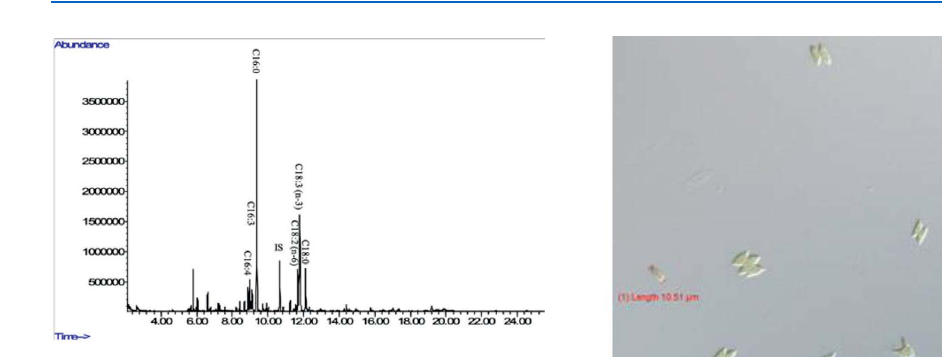
Fig. 5c. GC-MS chromatograms of FAME derived from freeze-dried biomass of freshwater green algae Chlorella vulgaris NIES-1269 (see Table 2 for peak identification). * Heptadecanoic acid (C17:0) was used as an internal standard.